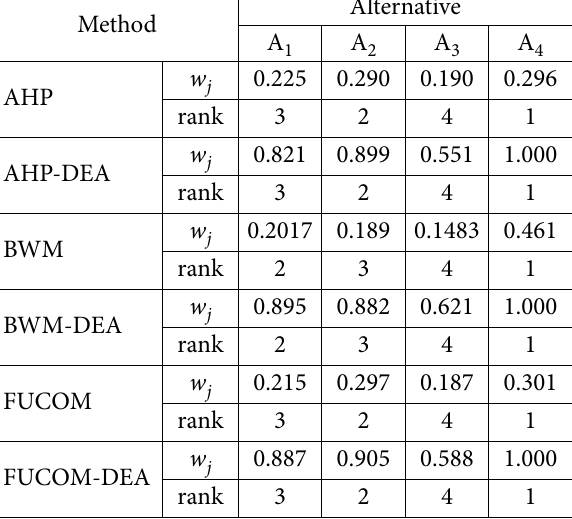
Table 10. Alternative ranks obtained by BWM, FUCOM, AHP and DEA